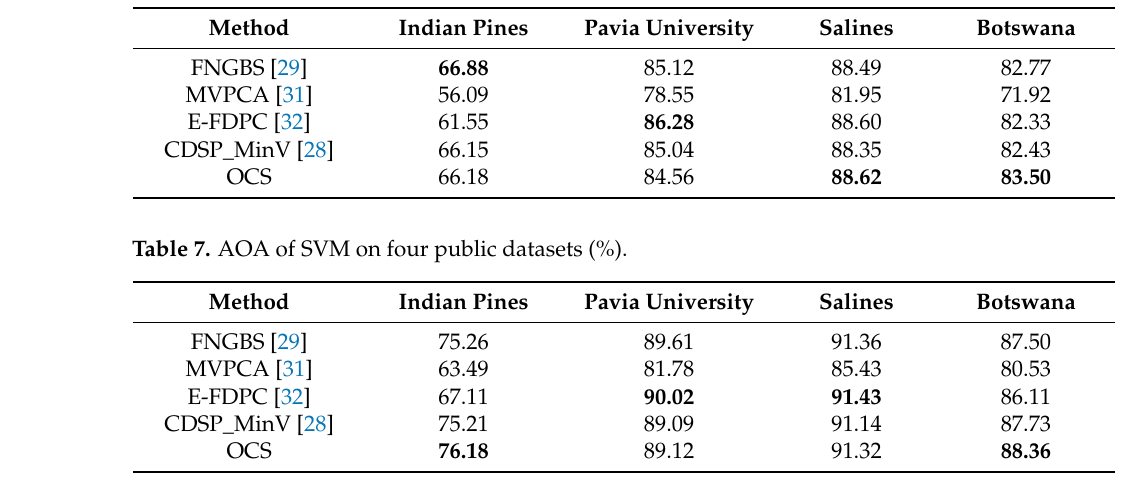
Figure 6. The OA curves of SVM on different datasets. ( a ) Indian Pines; ( b ) Pavia University; ( c ) Salinas; and ( d ) Botswana. Table 6. AOA of KNN on four public datasets (%).